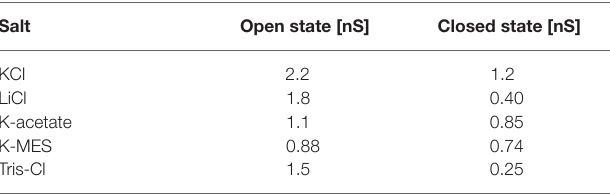
The pH of the aqueous salt solutions was adjusted to 7.2. The membrane voltage was 10 mV at the cis-side. The aqueous phase contained in the measurements of the closed state 0.1 μ g/ml polyanion added to the